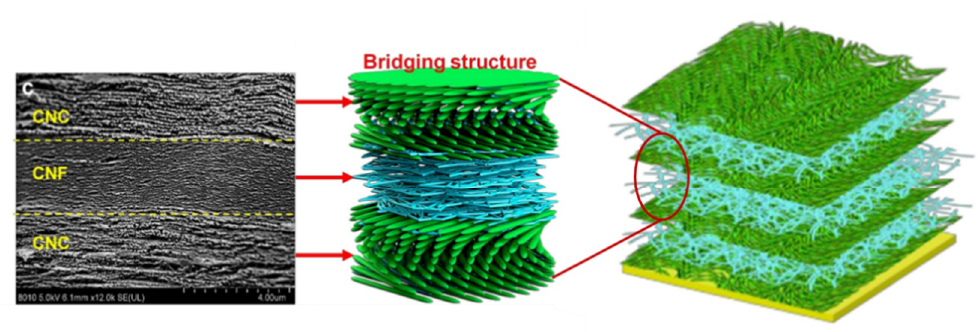
Figure 10. Schematic of chiral nematic cellulose nanofiber / random cellulose nanofiber (CNC–CNF) biocomposite with an alternating sequence of layers and corresponding SEM image of layers. Adapted from [199].